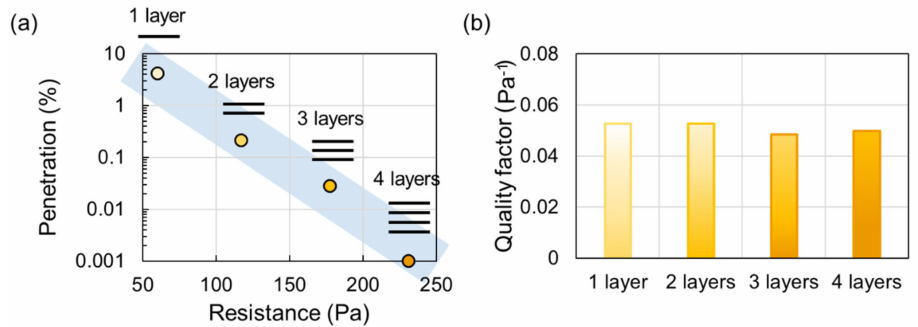
Figure 5. E ff ect of layers on filtration performance. ( a ) E ff ect of layers on penetration and resistance; ( b ) E ff ect of layers on quality factor. Tests were conducted with NaCl particles at 85 LPM by the